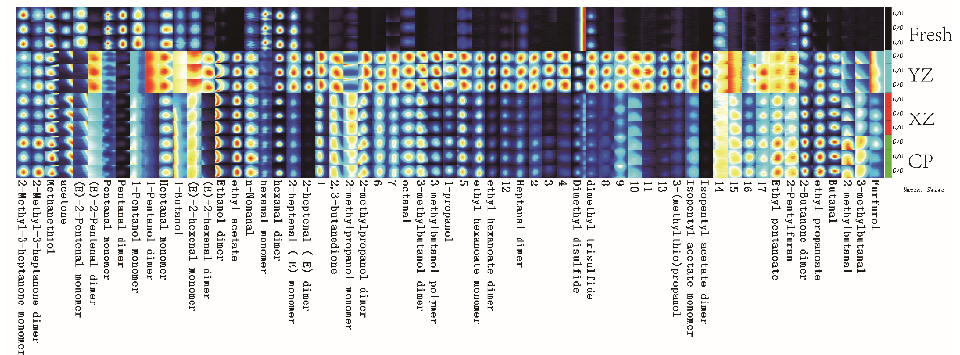
Figure 3. Fingerprints of VOCs isolated from different stages using GC–IMS. Each colored point represents a VOC, and different colors indicate varying concentrations, red representing higher intensity, blank meant not present. Fresh: raw sample; YZ: cured sample; XZ: smoking sample; CP: finished sample; VOCs: volatile organic compounds.